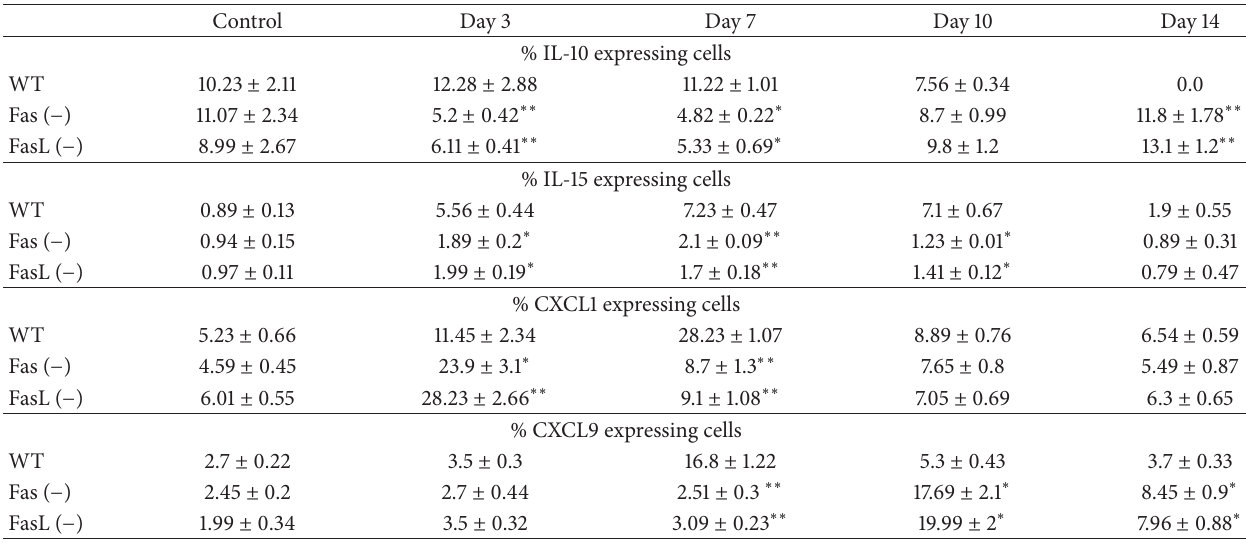
Table 2: Percentages of cells expressing IL-10, IL-15, CXCL1, and CXCL9 in the lungs isolated from ECTV-infected Fas ( − ), FasL ( − ), and WT (C57BL/6) mice at 3rd, 7th, 10th, and 14th days of infection and uninfected controls. All results represent means from 3 separate experiments ±